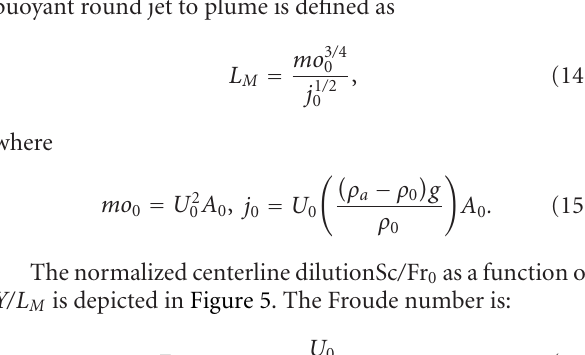
and the Boussinesq-based CorJet model.